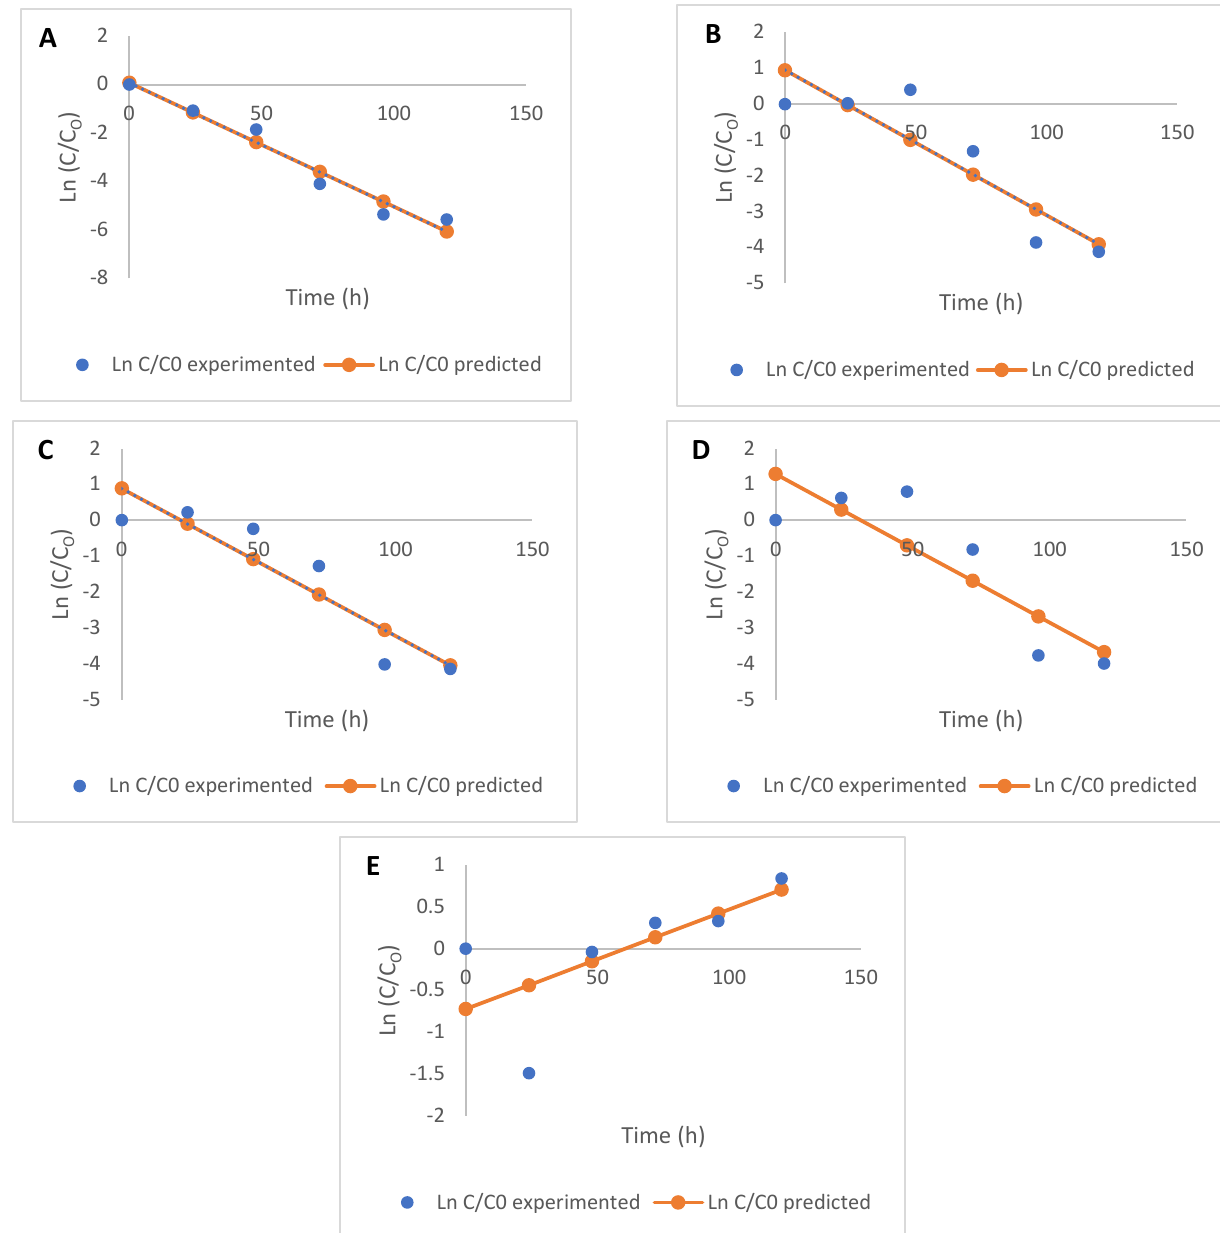
Figure 2. Kinetics (first-order) of free flavonoid degradation during the fermentation of maize flour ( A ) apigenin, ( B ) kaempferol, ( C ) luteolin, ( D ) quercetin, and ( E ) taxifolin.